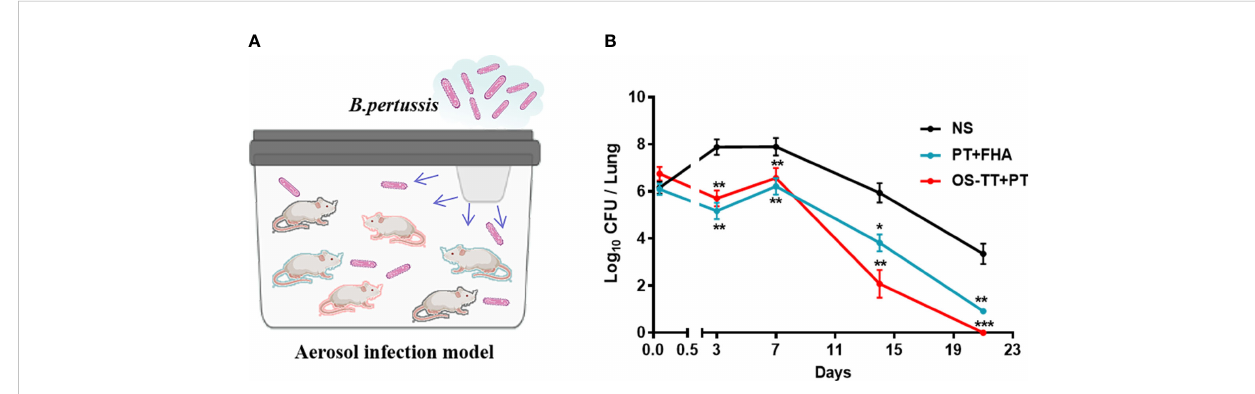
FIGURE 5 Ef fi cacy evaluation of the OS-TT+PT vaccine. Schematic illustration of the aerosol infection experiment. (B) Mice were infected with the B. pertussis Tohama I strain (2.0×10 9 CFU/mouse), and the bacterial burden in the lungs was assessed by performing CFU counts on lung homogenates at the time points indicated. NS: normal saline. Data shown are from one representative of three independent experiments. Data in B (n=4) are shown as the mean ± SEM. Signi fi cance was calculated using one-way ANOVA with multiple comparison tests (vs. NS; ∗ p < 0.05; ∗∗ p < 0.01; ∗∗∗ p <